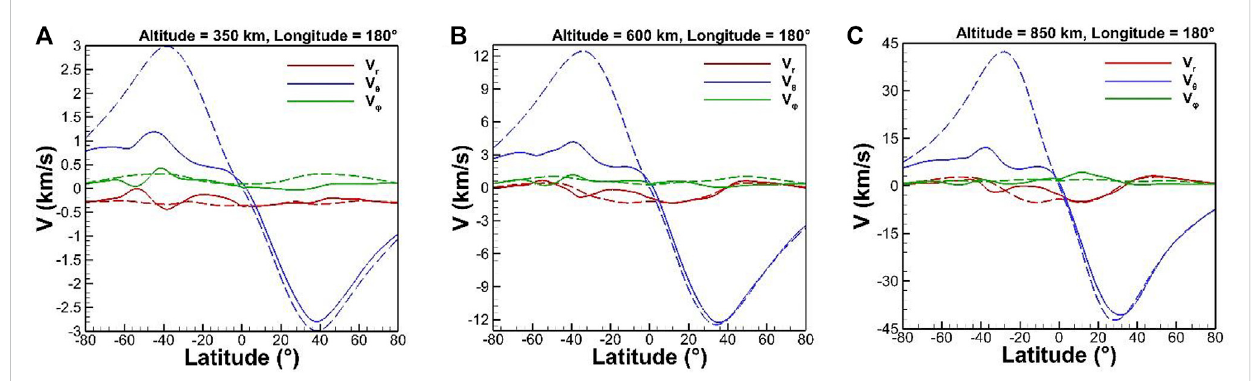
FIGURE 3 V r , V θ , and V φ along the 180 ° W MSO longitude line at different altitudes. (A) 350 km; (B) 600 km; (C) 850 km. Solid/Dashed lines represent the case with/without the crustal fi